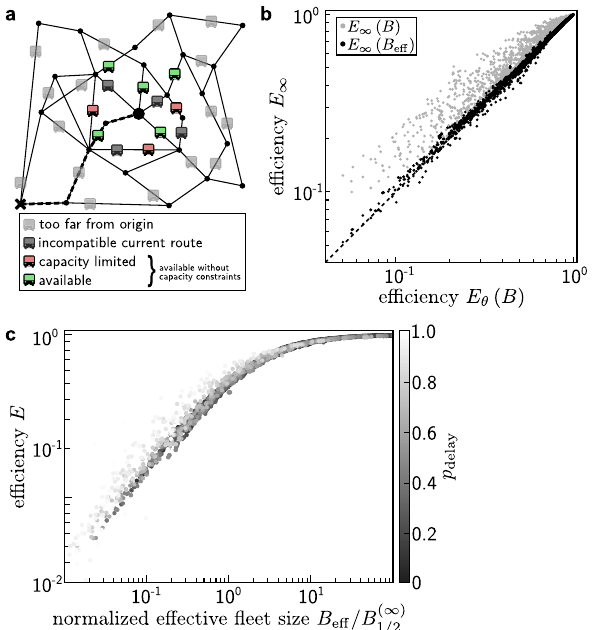
Figure 3. Effective fleet sizes capture the impact of capacity constraints. ( a ) When a new request (black circle, center) arrives, it must be assigned to one of the ride-pooling vehicles in the system. The number of feasible vehicles to serve the request is limited due to the large distance to the origin of many vehicles (light gray) or incompatible planned routes of close-by vehicles (dark gray). In a system without capacity constraints, the request would be assigned to the best of the remaining vehicles. However, a fraction p delay of these vehicles cannot serve the request due to the capacity constraints (light red). This argument suggests that the ride- pooling dynamics of a capacity-constrained system is similar to the dynamics of an unconstrained system with a reduced effective fleet size B eff = ( 1 − p delay ) B , Eq. (6). ( b ) The efficiency E θ ( B ) of capacity-constrained systems is approximately equal to the efficiency of unconstrained systems E ∞ ( B eff ) with the reduced effective fleet size B eff (black dots). Comparing both systems with the same fleet size, the efficiencies differ significantly (light gray). The figure shows results for more than 3000 distinct settings ( T , B , x , θ) where p delay ≤ 0.8 . c With the normalized effective fleet size as the scaling parameter, the efficiency of capacity-constrained ride- pooling services collapses to the same universal efficiency function as the unconstrained system across different topologies, capacity constraints, and system loads x . Deviations occur when most vehicles are fully occupied, p delay ≈ 1 (light dots, see main text). See “Methods” for details on the settings and